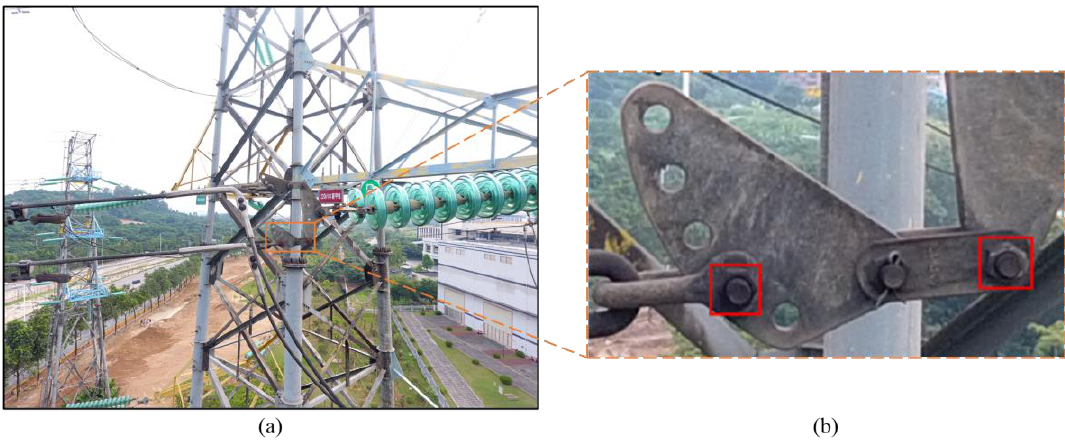
Figure 7 . Results of pin defects detection in the UAV images by using the method in this paper. (a) is the output detection result of UAV images, and (b) zooms in the orange box in